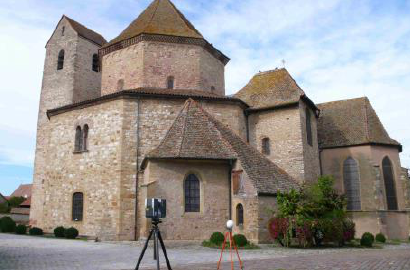
Figure 1. Abbey-church of Ottmarsheim